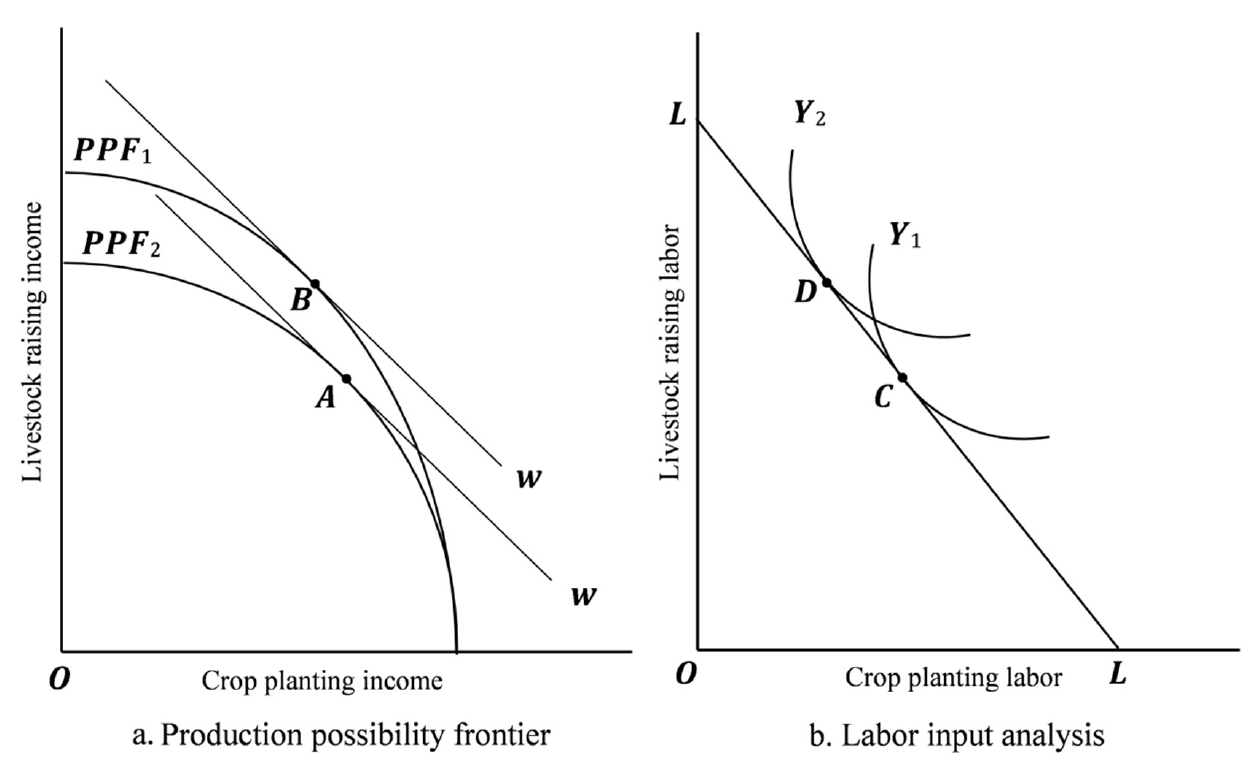
Figure 3. Different rural households’ labor input analysis and production possibility frontier (PPF). ( a ) Production possibility frontier when livestock breeding income changes. ( b ) Labor input under different income levels.